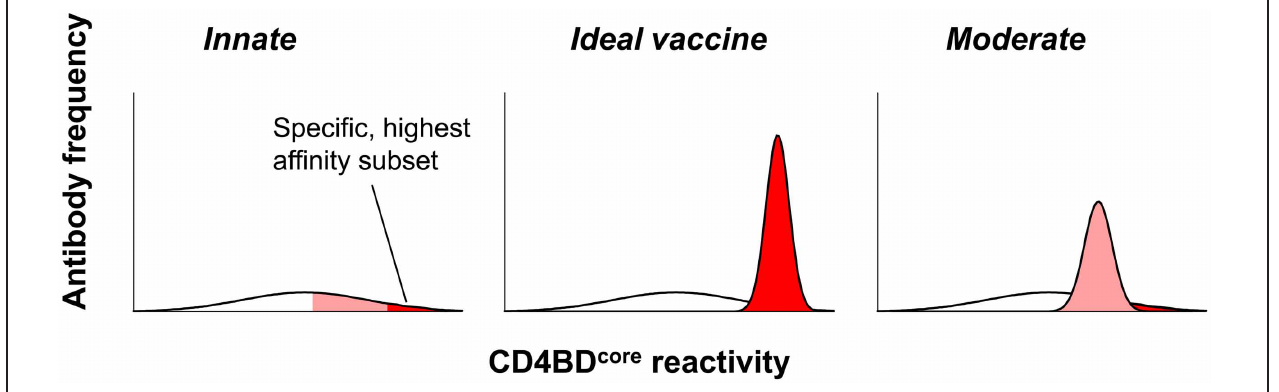
FIGURE 4 | Constitutive CD4BD core -reactive antibodies pertinent to HIV vaccination. Left panel: model of innate germline antibody repertoire containing a wide range of antibodies with varying CD4BD core -reactivity and HIV neutralizing potency. A small antibody subset with the greatest CD4BD core -reactivity is hypothesized to possess potent and broad neutralizing activity (red). Middle panel: